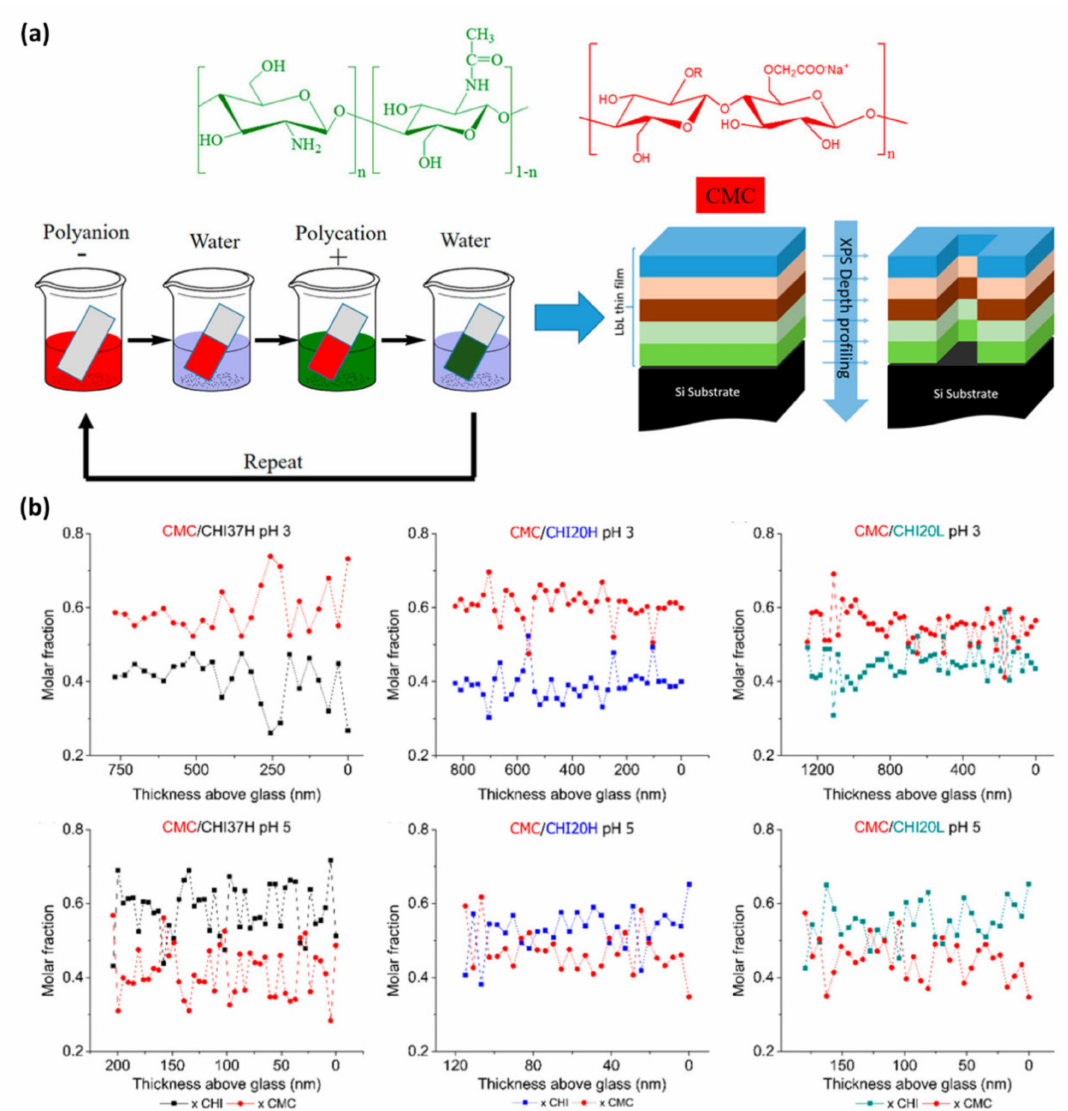
Figure 11. ( a ) Schematic illustration of preparation of layer-by-layer method using chitosan and XPS depth profiling. ( b ) Depth profiling of CMC / CHI systems (Reproduced with permission from Reference [59]; Copyright (2018) American Chemical